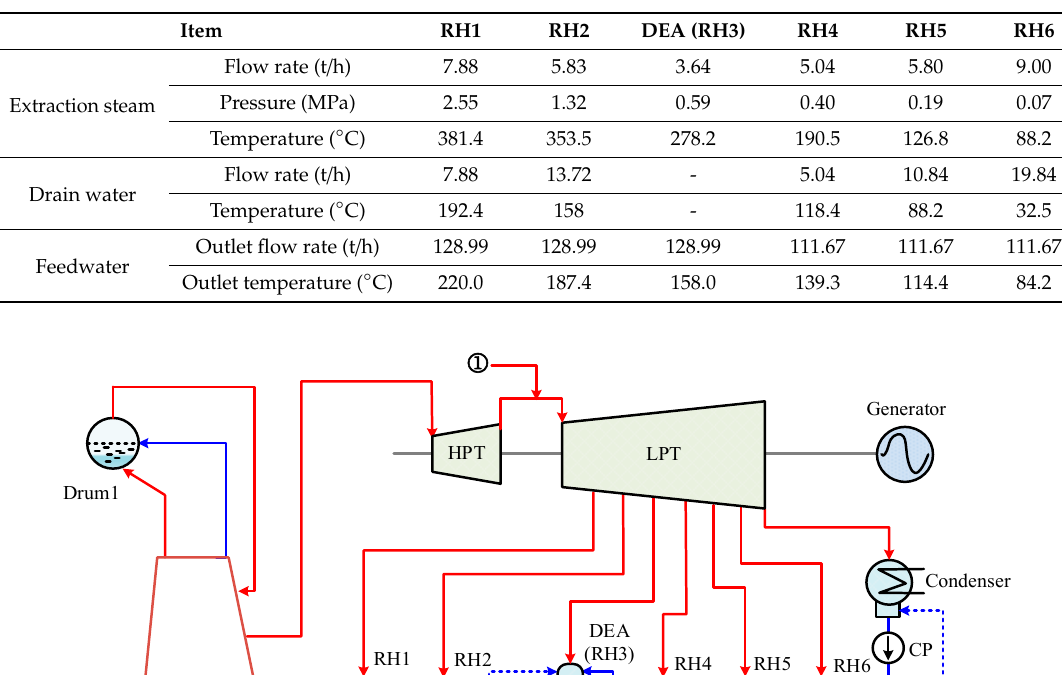
Table 5. Parameters of the heat regeneration system in the reference biomass-fired power plant.